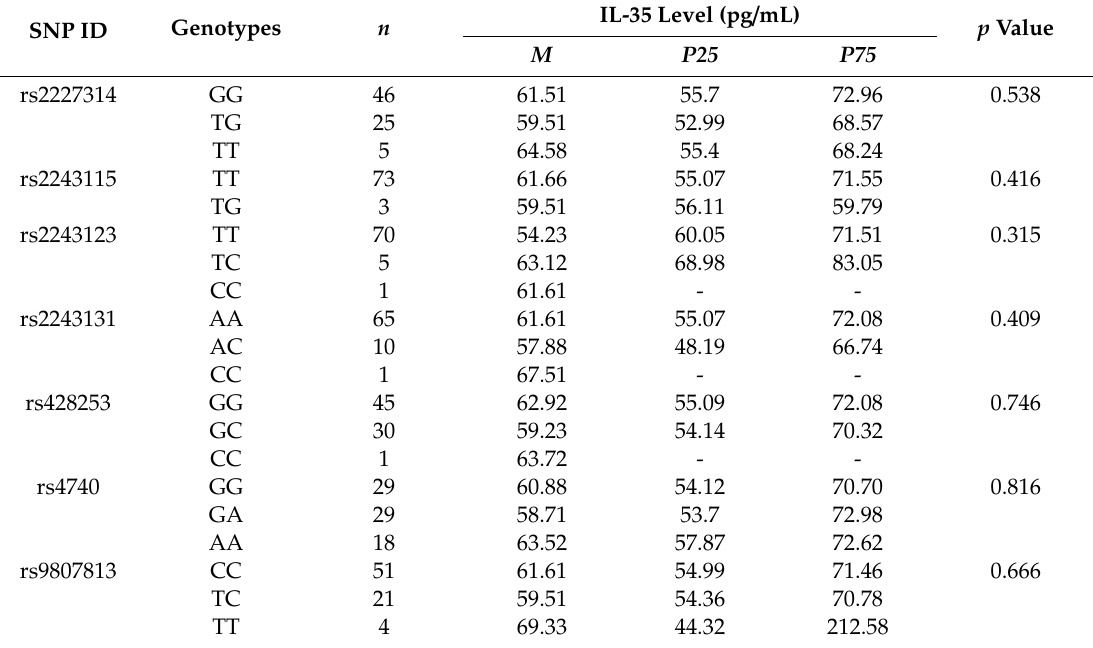
Table 4. Associations of plasma IL-35 levels with IL-35 genotypes in SLE patients.